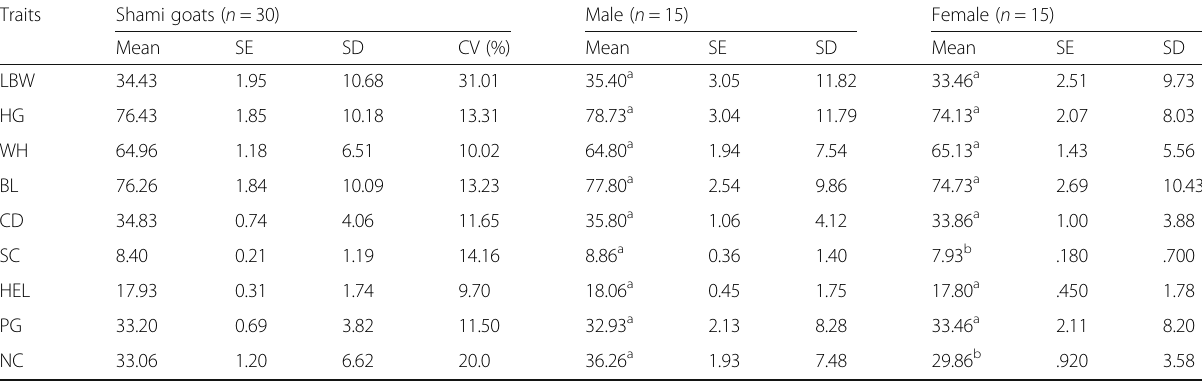
Table 1 Descriptive statistics of the morphological traits of Shami goats based on sex